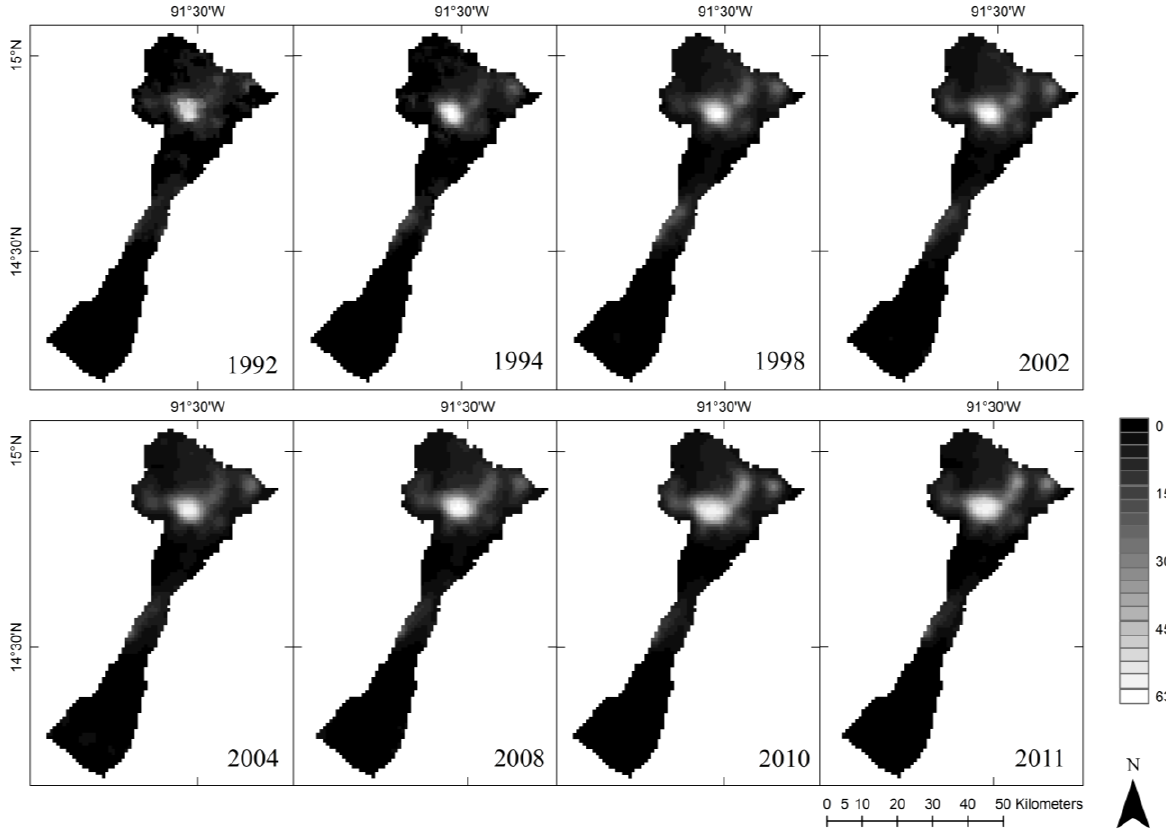
Figure 2. Temporal evolution of nighttime lights in the Samala River catchment. Images show the intercalibrated values of nightlights in different years to expose how the brightness has increased over the years. Images for 1994, 1998, 2002, and 2004 show the averaged intercalibrated values of the two available satellites (the boundary of the catchment corresponds to Figure 1). Original image and data processing by NOAA’s National Geophysical Data Center. DMSP data collected by US Air Force Weather Agency. Intercalibrated images: the